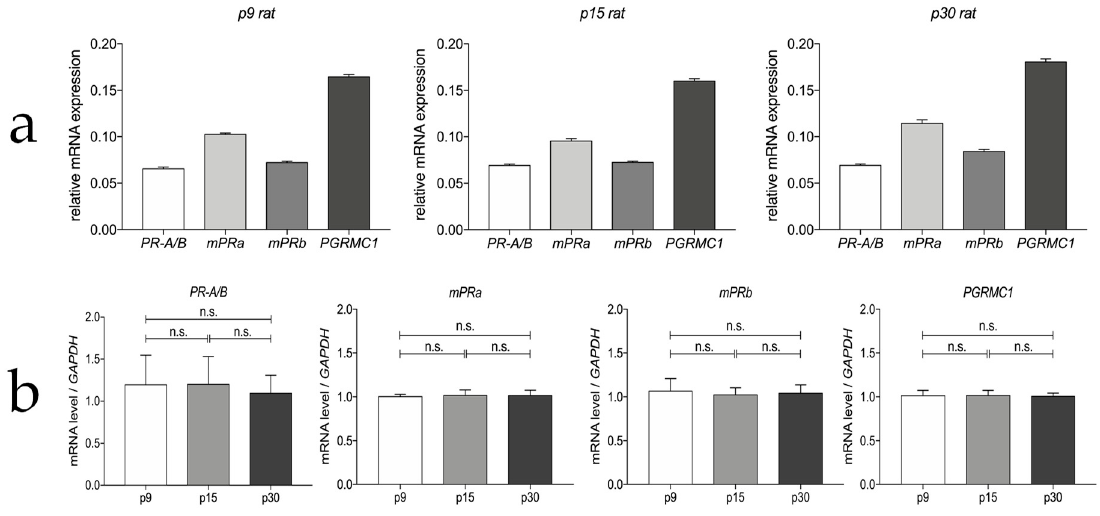
Figure 2. RT-qPCR analysis of progesterone receptor mRNA expression. ( a ) Comparison of relative concentration levels of each receptor mRNA at three different ages (p9, p15 and p30) using the reciprocal of ∆ Ct; ( b ) Comparison of the shift of expression levels of each receptor during development, which were normalized to the expression of the housekeeping gene GAPDH. Data are shown as mean ± SEM (n ≥ 3), with dissected myenteric ganglia of about 15 rats per age. ANOVA was used to compare the different ages, changes > 0.05 were considered significant, otherwise they were marked as not significant